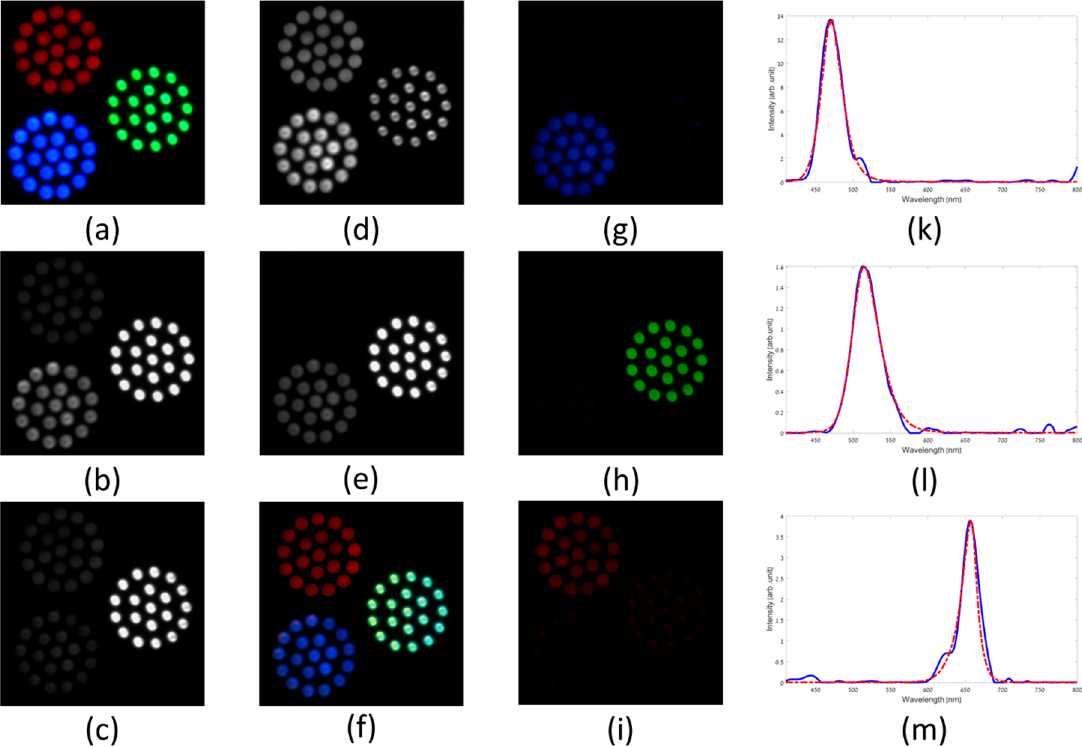
Figure 7. Staring mode reconstruction result of three LED arrays. ( a ) RGB color image of three LED arrays that were used as objects to be imaged with CS-MUSI. ( b – e ) Representative single exposure images for LC cell voltage of 0 V, 5.8373 V, 7.6301 V and 8.6552 V, respectively. ( f ) RGB representation of the reconstructed HS image (700 × 700 pixels × 391 bands). ( g – i ) Reconstructed images at 460 nm, 520 nm and 650 nm, respectively. ( k – m ) Spectrum reconstruction for three points in the HS datacube and comparison to the measured spectra of the three respective LEDs with a commercial grating-based spectrometer.